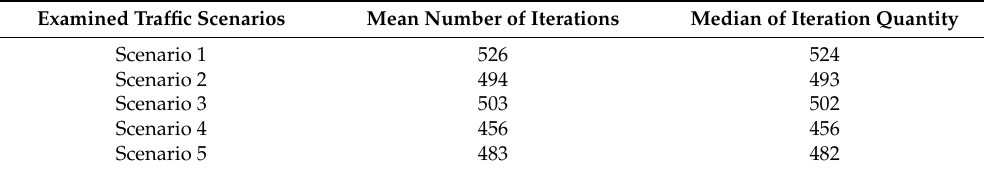
Table 4. Mean number of iterations and median of the iteration